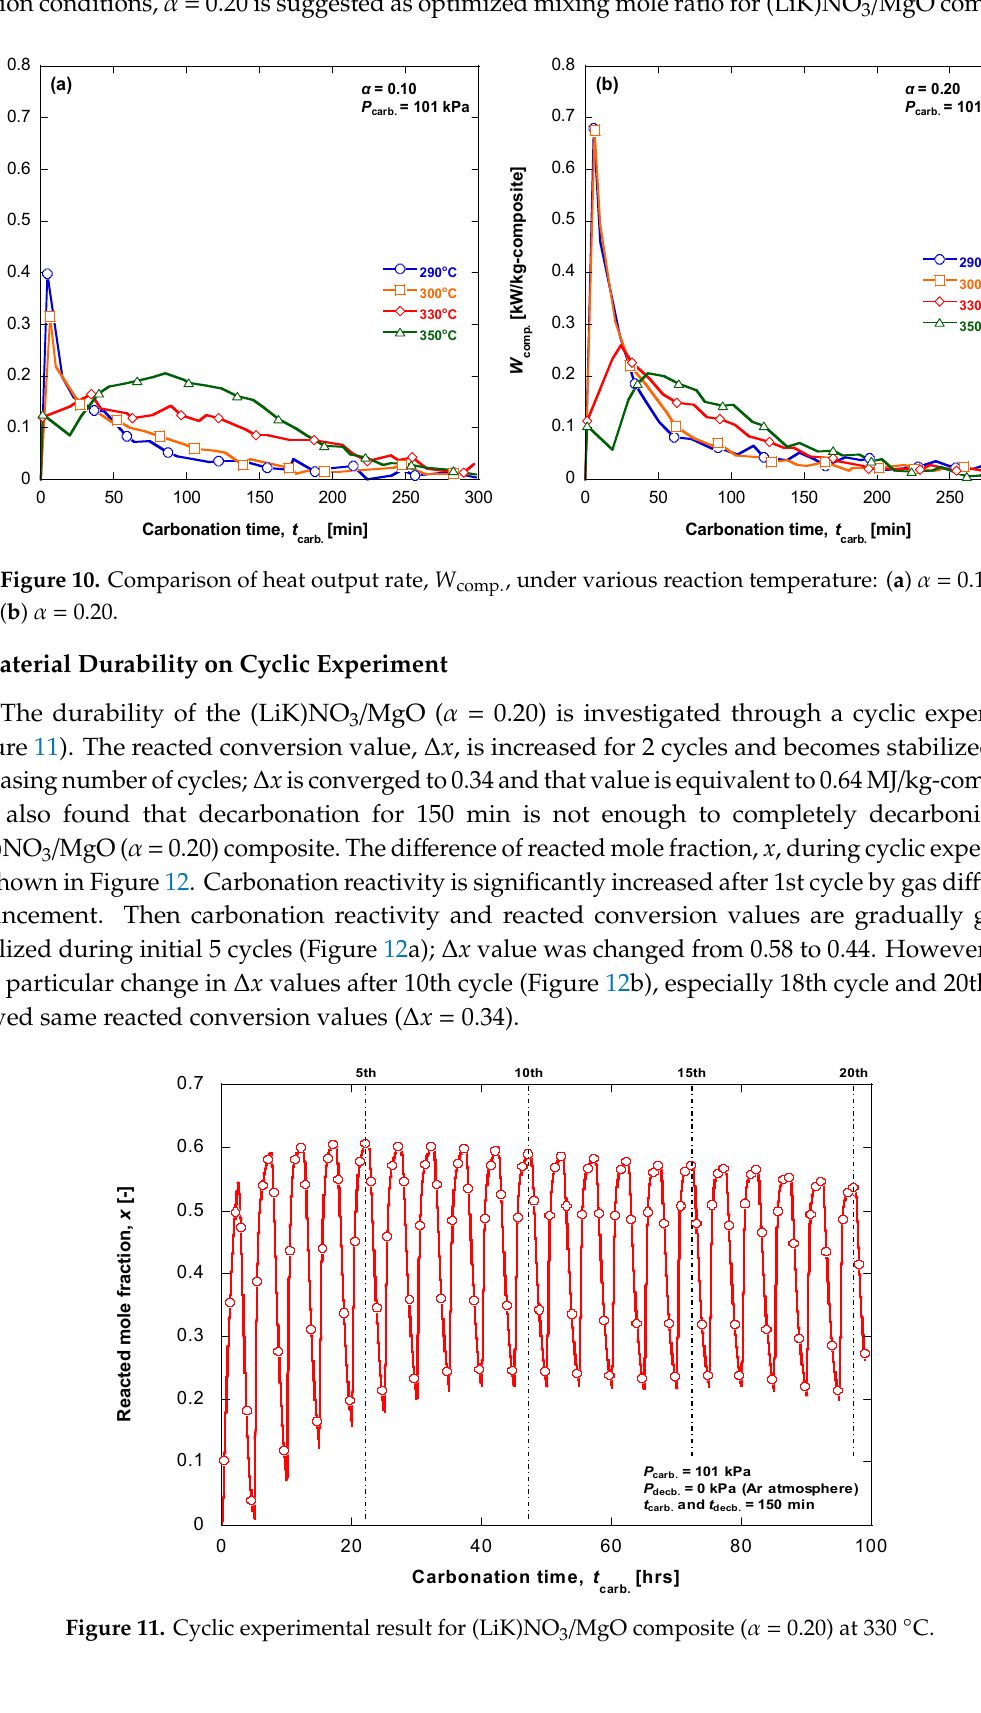
Figure 11. Cyclic experimental result for (LiK)NO 3 /MgO composite ( α = 0.20) at 330 °C.